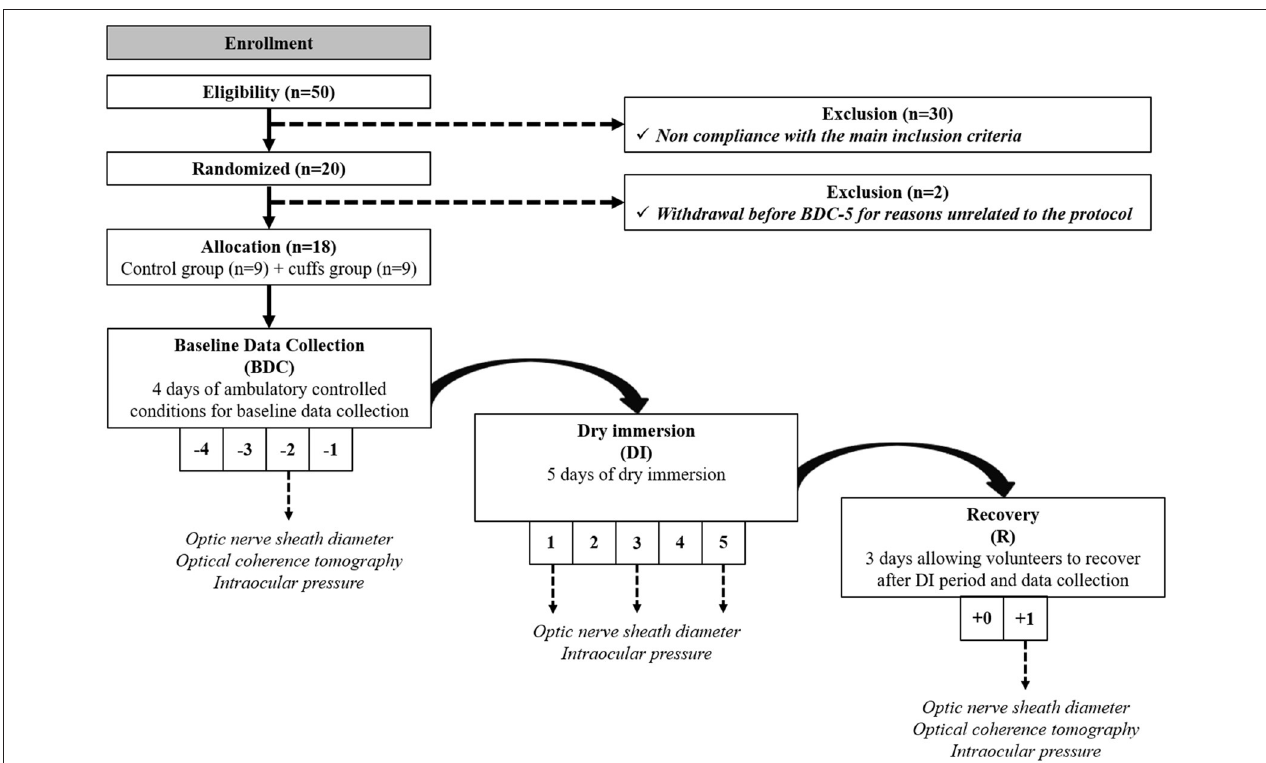
FIGURE 3 | Flow chart of the study and timeline of ophthalmological data